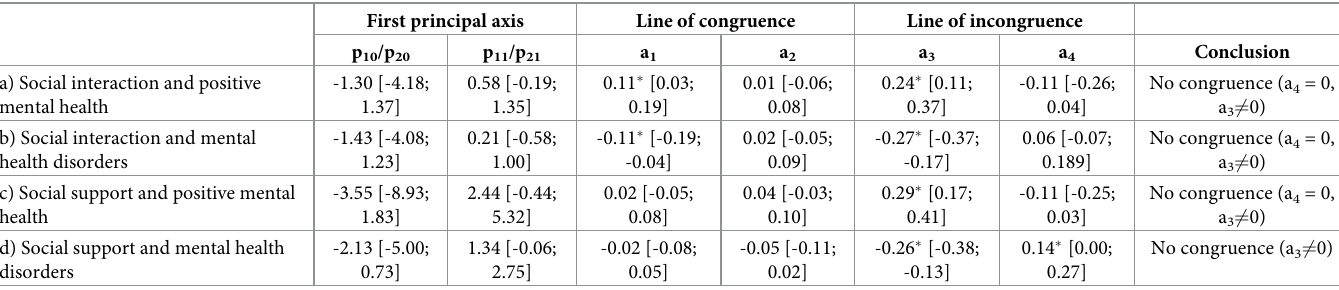
Table 4. Response surface